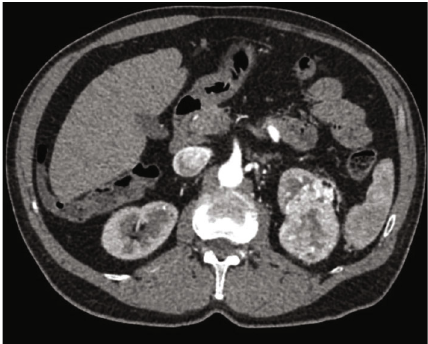
Figure 1: Axial CT scan showing posterior upper pole left enhancing renal mass concerning for malignancy.